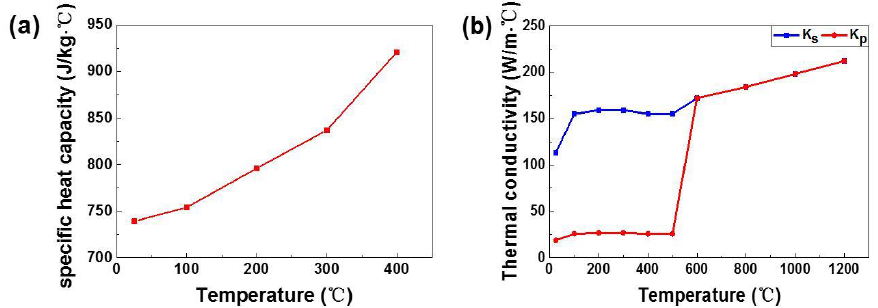
Figure 4. Temperature-dependent thermal properties: specific heat capacity ( a ) and the effective thermal conductivity of AlSi10Mg powder and solid ( b ).